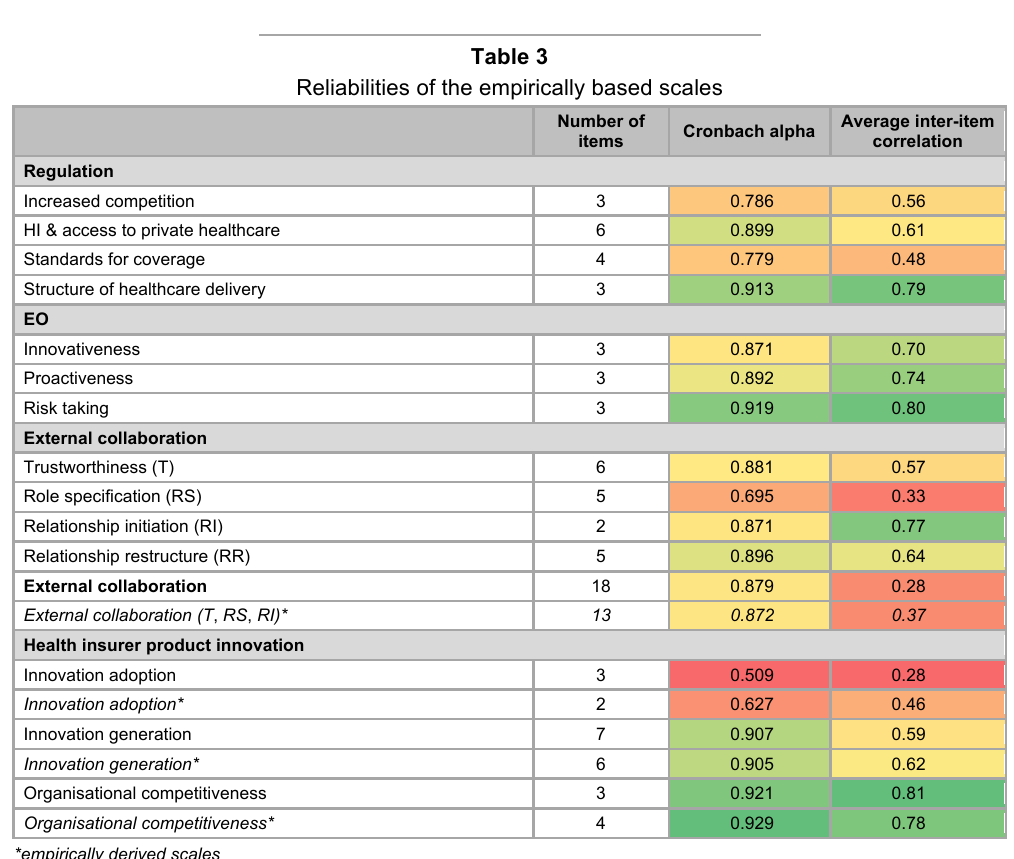
Reliabilities of the empirically based scales